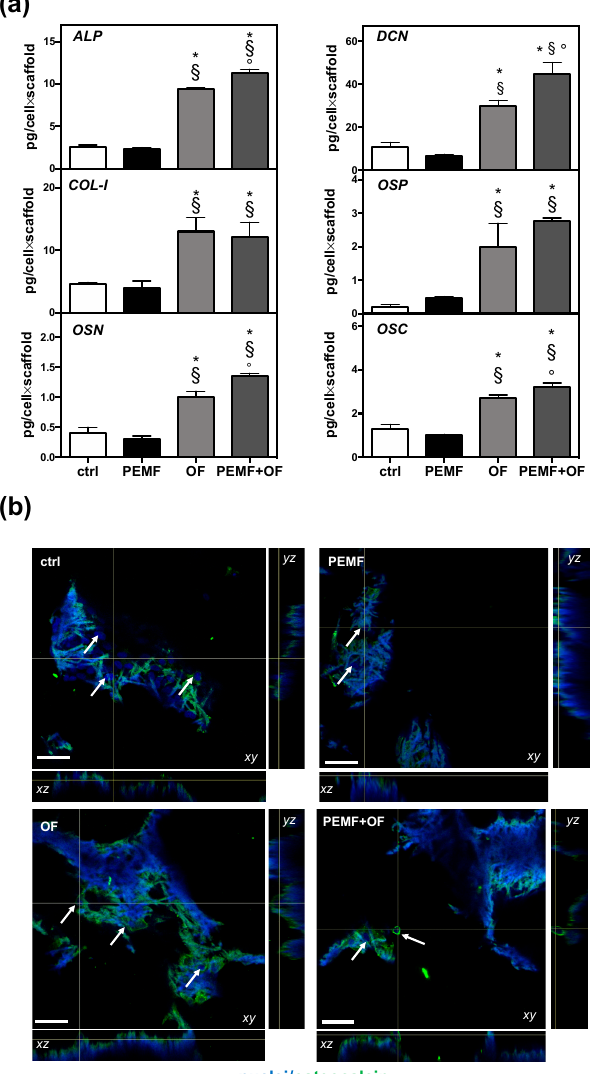
Figure 5. Bone osteogenic protein production by cells onto wool fibril sponges in the di ff erent conditions after 21 days of culture. ( a ) Quantification of indicated osteogenic proteins quantified by ELISA assay. Data are expressed as pg / cell × sca ff old (N = 3; n = 2, symbols indicate statistical significance vs. control (*), vs. PEMF (§) and vs. OF ( ◦ )). ( b ) Representative orthogonal view of Confocal Laser Scanning Microscope (CLSM) images of bone osteocalcin immunolocalization (green) are shown with xy, yz, and xz planes. Nuclei (blue) were counterstained with Hoechst 33342. White arrows indicate the sca ff old areas containing cells. Magnification 20 × ; the scale bar represents 50 µ m. Negative control for non-specific staining of the secondary antibody and Tissue Culture Plates (TCPS) controls are shown in Figure